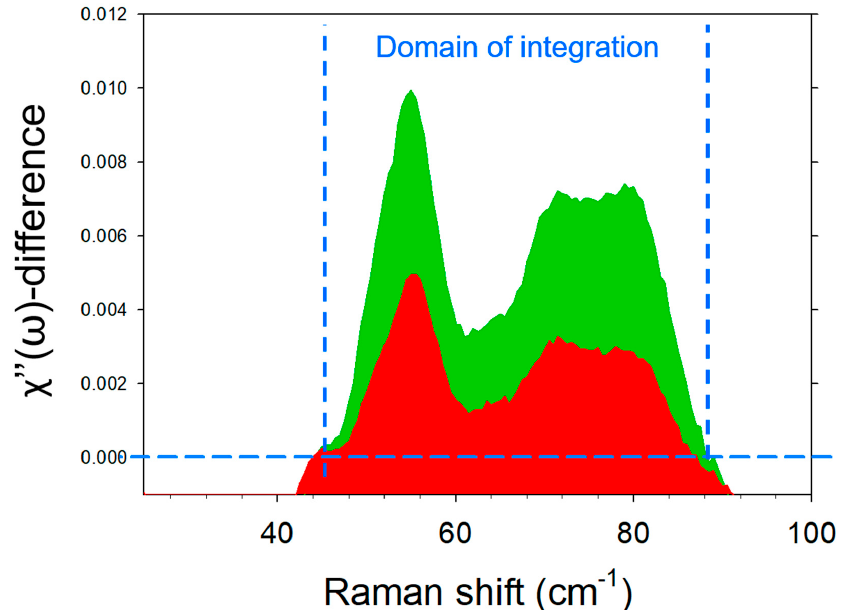
Figure A3. Spectrum difference in the Raman susceptibility representation between the crystal and amorphous states in the bulk form of ibuprofen (in green) and between ibuprofen confined in SBA-15 by MAL at 10 Hz (partially crystallized) and ibuprofen confined in SBA-15 by MAL (totally amorphous). The dashed blue lines indicate the domain of integration. Pharmaceutics 2023 , 15 , 390